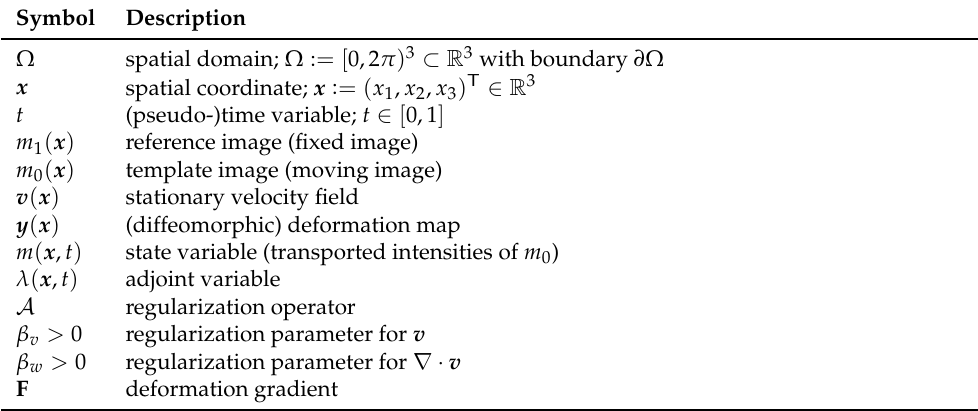
Table 1. Notation and main